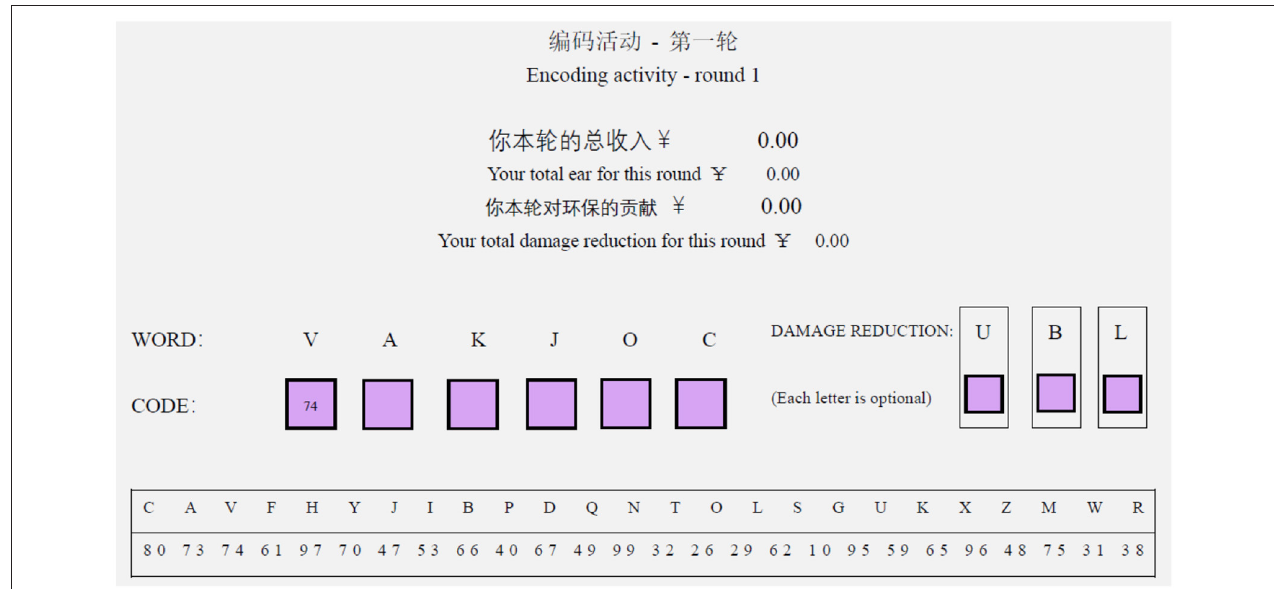
FIGURE 4 | Experimental paper of the main activity.